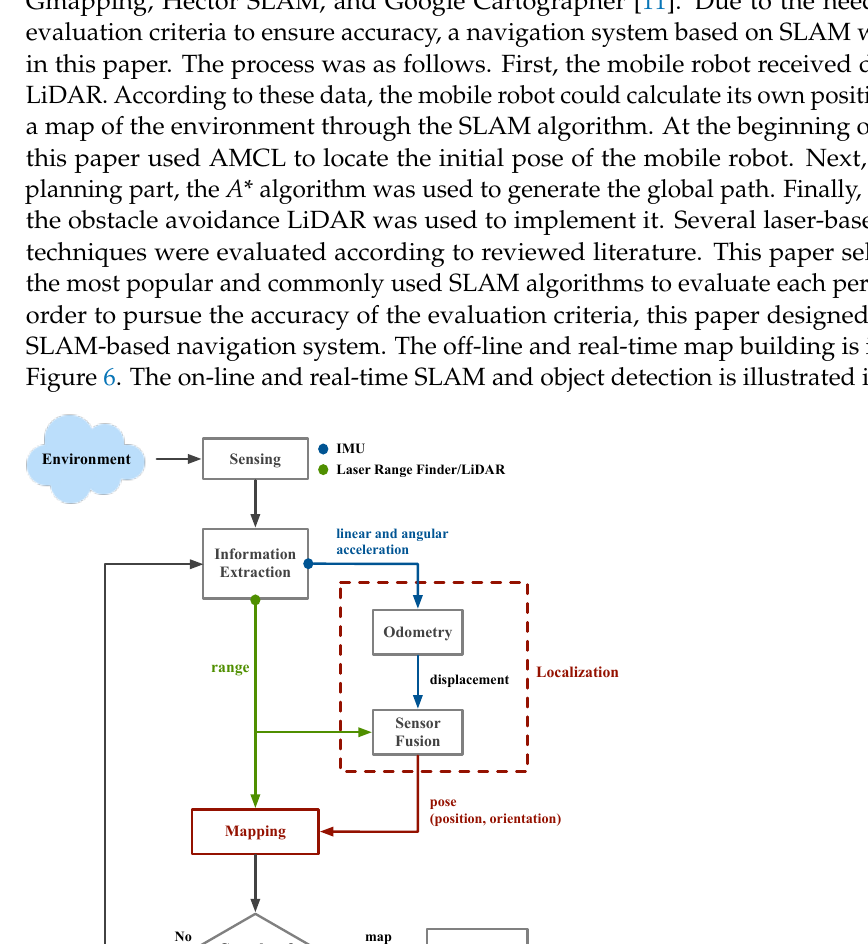
Figure 6. Off-line map-building workflow.